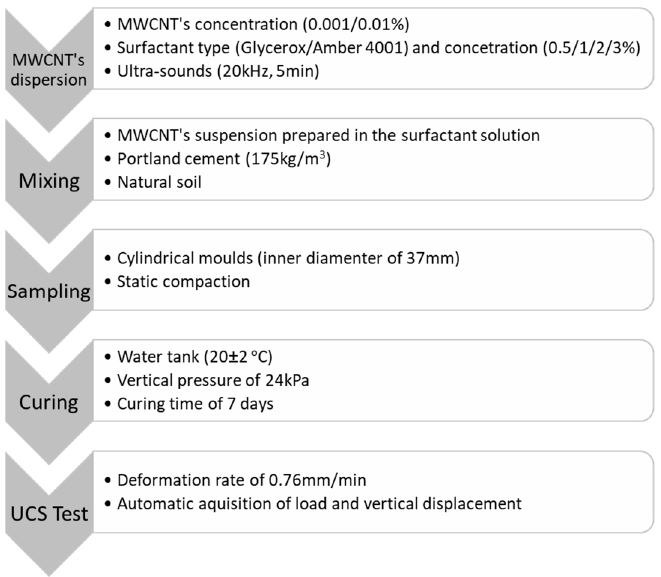
Figure 1. Schematic representation of the laboratory procedure.